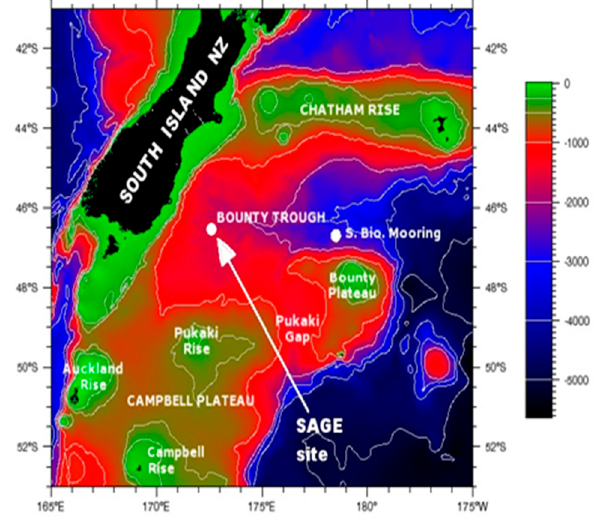
Figure 1. Location of the SOLAS Air–Sea Gas Exchange Experiment (SAGE) iron enrichment experiment Figure 1. (a) Location of the SOLAS Air–Sea Gas Exchange Experiment (SAGE) iron enrichment (white experiment (white circle).